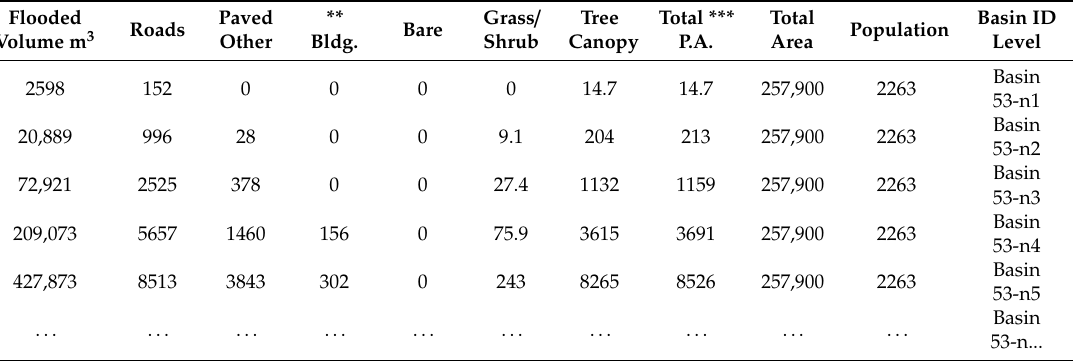
Table 1. Tabulated information for each basin connected to a corresponding